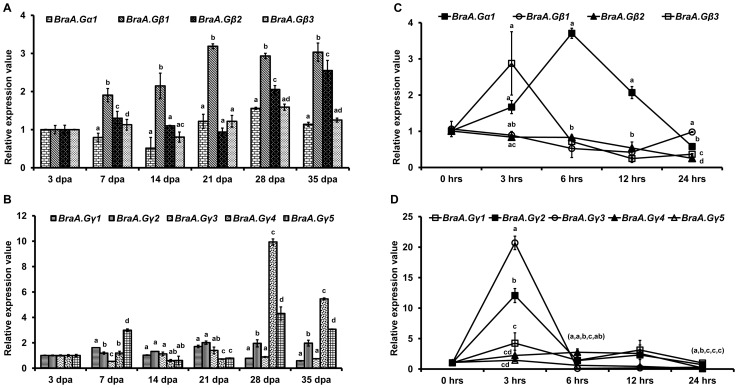
Expression pattern of B. rapa G-proteins during seed maturation (A, B) and seed germination (C, D).The relative expression of (A, C) BraA.Gα1 and BraGβ genes; and (B, D) BraGγ genes across different stages of seed-maturation (3, 7, 14, 21, 28, and 35 days post-anthesis; dpa), and seed-germination (0, 3, 6, 12 and 24 hrs post-imbibitions) of B. rapa. Total RNA was isolated from different tissues and the relative expression was quantified by qRT-PCR analysis and normalized against Brassica GAPDH (for seed-maturation) and Actin (for seed-germination). The (A, B) 3 dpa immature seeds and (C, D) 0 hrs (un-imbibed) seeds were used as reference tissue (expression set at 1). Three independent measurements were taken and the data were averaged. Bar represent the standard error of the mean. Different letters above represent significant difference at P<0.05 using Fisher's LSD test. Letters within the parenthesis represent significance for BraA.Gγ1-BraA.Gγ5, in series.